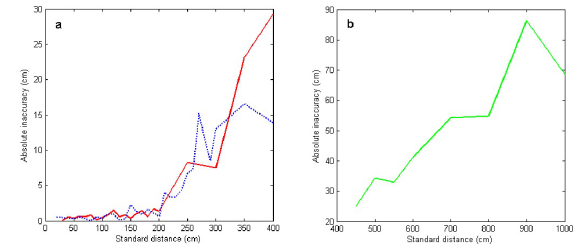
Figure 7: The diagram of dependence of absolute inaccuracy on the distance. (a) For short distances. The solid red line: b = 9.7 cm , manual calibration "by sight". The dashed blue line: b = 9.7 cm , with application of the specialized calibration procedure. (b) For far distances, with application of the specialized calibration procedure with the use of b = 51.15 cm